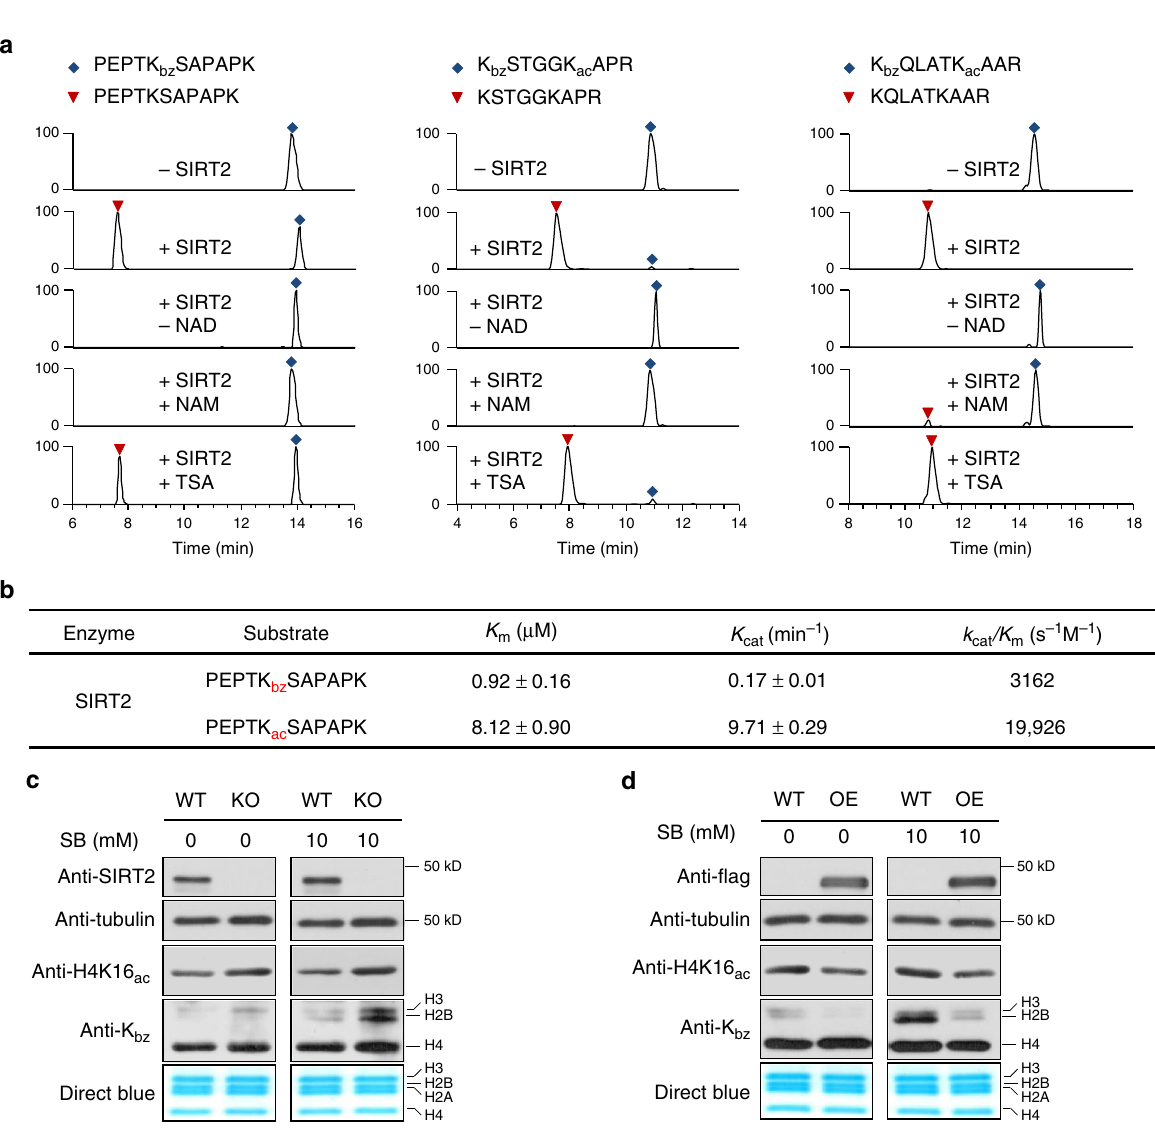
Fig. 5 SIRT2 catalyzes histone lysine de-benzoylation both in vitro and in vivo. a SIRT2 can catalyze in vitro debenzoylation reactions of 3 synthetic K bz peptide substrates. b Kinetics data for SIRT2 on acetyl and benzoyl histone H2AK5 peptides. c Core histone K bz increased in SIRT2 knockout (KO) MEF cells. Whole-cell extracts were probed for the presence of SIRT2 and tubulin by western blot. Acid-extracted histones were tested for H4K16 ac and global K bz levels by western blot. Total histones levels were visualized with Coomassie blue staining. d Core histone lysine benzoylation decreased in SIRT2 overexpressing (OE) cells. Flag-SIRT2 was transfected into HEK293T cells for 48 h. Whole-cell extracts were probed for the presence of Flag-SIRT2 and tubulin by western blot. Acid-extracted histones were tested for H4K16 ac and global K bz levels by western blot. Total histones levels were visualized with Coomassie blue